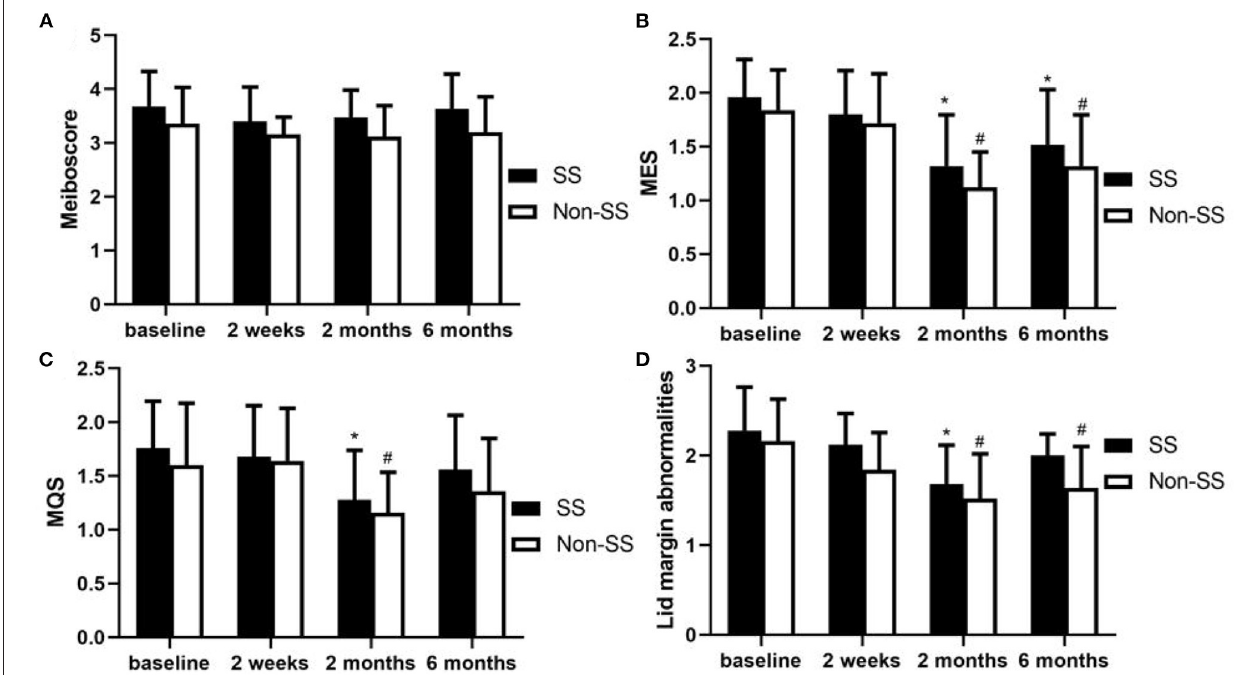
FIGURE 2 | Changes of Meiboscore, MES, MQS and Lid margin abnormality score after punctal plugs insertion. (A) There was no statistically significant difference between the two groups in the mean meiboscores at baseline, 2 weeks, 2 and 6 months ( P > 0.05, respectively). Compared with the baseline, the meiboscores did not change significantly at every visit in both groups. (B) The MES had no difference between the two groups at baseline and every visit (all P > 0.05). Compared with the baseline, the MES was improved at 2 and 6 months in both groups ( P < 0.05, respectively). (C) There was no obvious difference of MQS between the two groups at baseline and every visit (all P > 0.05). Compared with the baseline, the decrease of MQS was statistically significant only at 2 months in both groups. (D) There was no statistical difference in the scores of lid margin abnormalities at baseline and every visit between the two groups ( P > 0.05). After punctal plugs insertion, compared with the baseline, lid margin abnormalities scores were significantly improved in non-SS group at 2 and 6 months ( P < 0.05, respectively). While SS group showed statistical difference only at 2 months ( P < 0.05). (* p < 0.05 in SS vs. baseline, # p < 0.05 in non-SS vs.